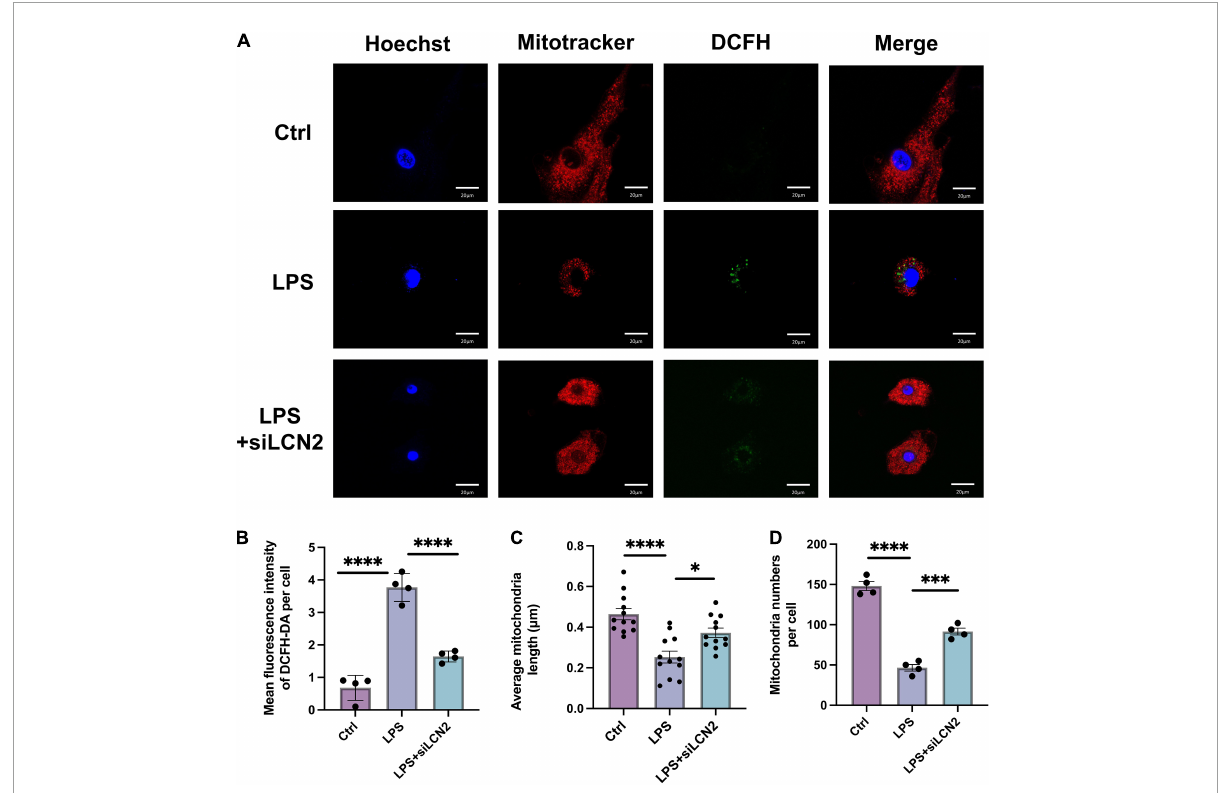
FIGURE5 The suppression of LCN-2 protected mitochondrial morphology and limited the production of ROS. (A) Mitochondrial morphology (MitoTracker, red) and ROS level (DCFH-DA, green) of LPS damaged H9C2 cardiomyocytes pretreated with siLCN2 ( n = 3; scale bar = 20 µ m). (B) Mean fluorescence intensity of DCFH-DA ( n = 4). (C) Average mitochondria length of cardiomyocytes in TEM ( n = 12). (D) Average number of mitochondria of cardiomyocytes ( n = 4). Data are presented as mean ± SEM. Statistical analysis was via one-way ANOVA with Bonferroni multiple-comparison correction; ∗ P < 0.05, ∗∗ P < 0.01, ∗∗∗ P < 0.001, and ∗∗∗∗ P < 0.0001.